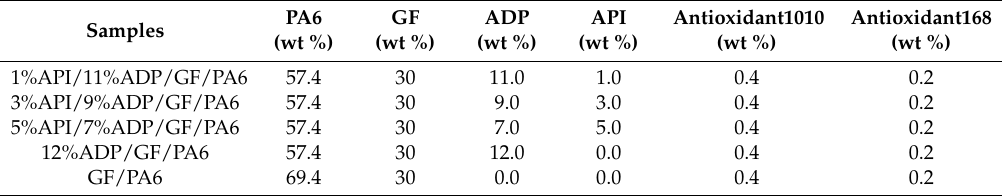
Table 1. Formulae of flame retardant PA6